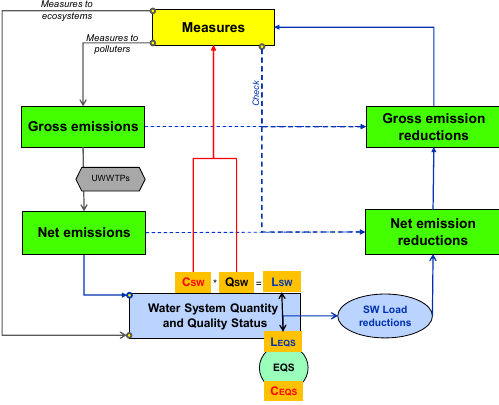
Figure 7. Measures based on a water balance. A complete and workable balance requires the introduction of the notion of ‘net emission’ (entering the surface water (SW) body) beside ‘gross emission’ (leaving the pollution source). Environmental status (S) depends on the monitoring of water quantity and quality. Source-oriented measures intend to regulate the polluter’s impact by limiting emissions, possibly by means of urban wastewater treatment plants (UWWTPs); effect-oriented measures aim to restore natural conditions of ecosystems. ‘Measures’ is about decision-making that depends on monitoring of the environmental status. The schema includes a flow- (Q-), concentration- (C-) and load- (L-)based approach (with Q * C = L). Decision-making using a C-based approach is a widely applied, less secure trial-and-error strategy that systematically compares the monitored parameter concentration (C SW ) with environmental quality standards (EQSs) (C EQS ). Calculation of load reductions allows the definition of measures at both the ecosystem level (net emission reductions) and the polluter level (gross emission